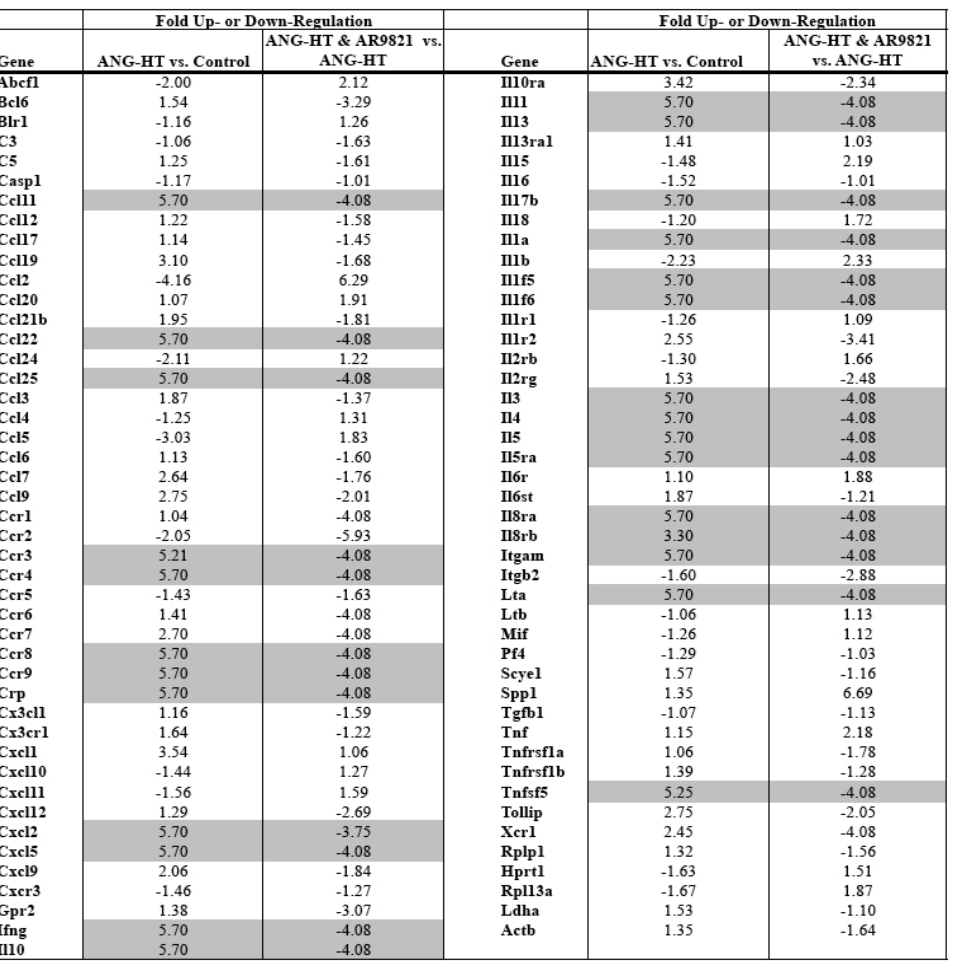
Table 1. Renal inflammatory gene expression changes in angiotensin-infused rats (ANG HT). Renal proinflammatory mRNA expression increased in ANG HT and AR9821 decreased proinflammatory gene expression in ANG HT. Grey shading highlights genes increased greater than 3-fold by hypertension and decreased 3-fold by